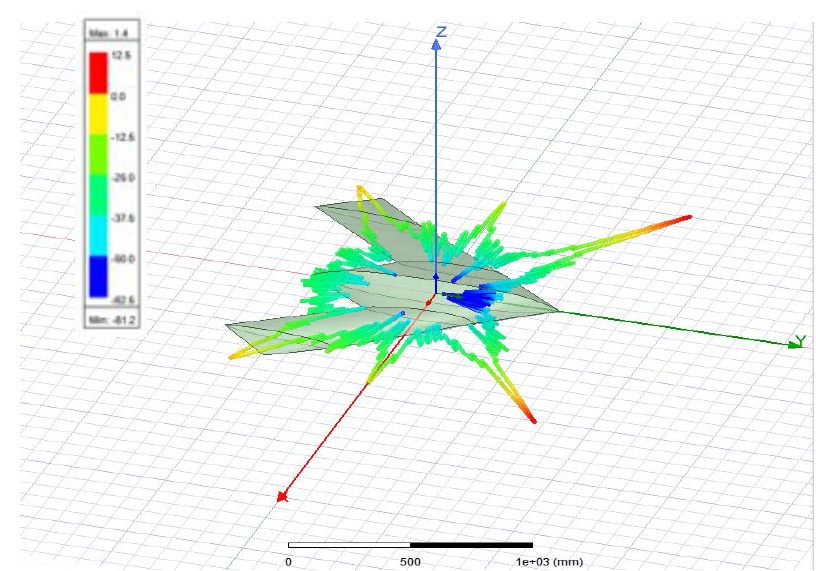
Figure 11. 3D RCS Plots over the entire surface of the UCAV